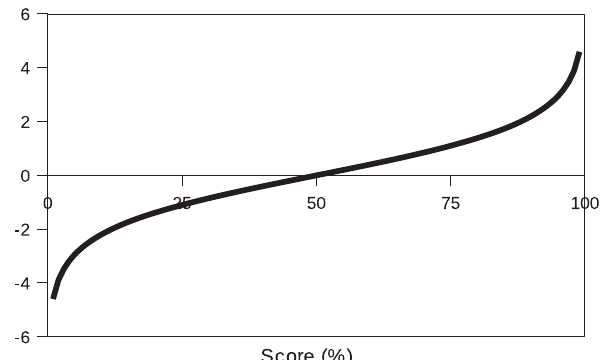
FIG. 1. The logit function. Vertical abscissa is 0 . 6 ln ½ p= ð 1 − p Þ(cid:2) , where p is given by the horizontal